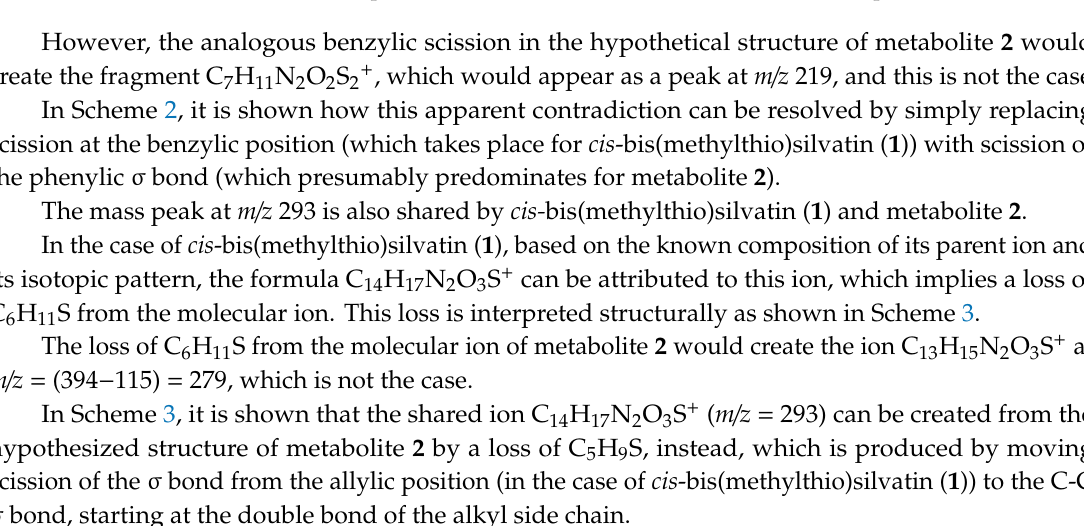
Scheme 3 Substructure colored in red has been assigned to ion C 14 H 17 N 2 O 3 S + at m/z =293 in Figure 5, while substructures in black represent the neutral losses for its formation from the parent ion.